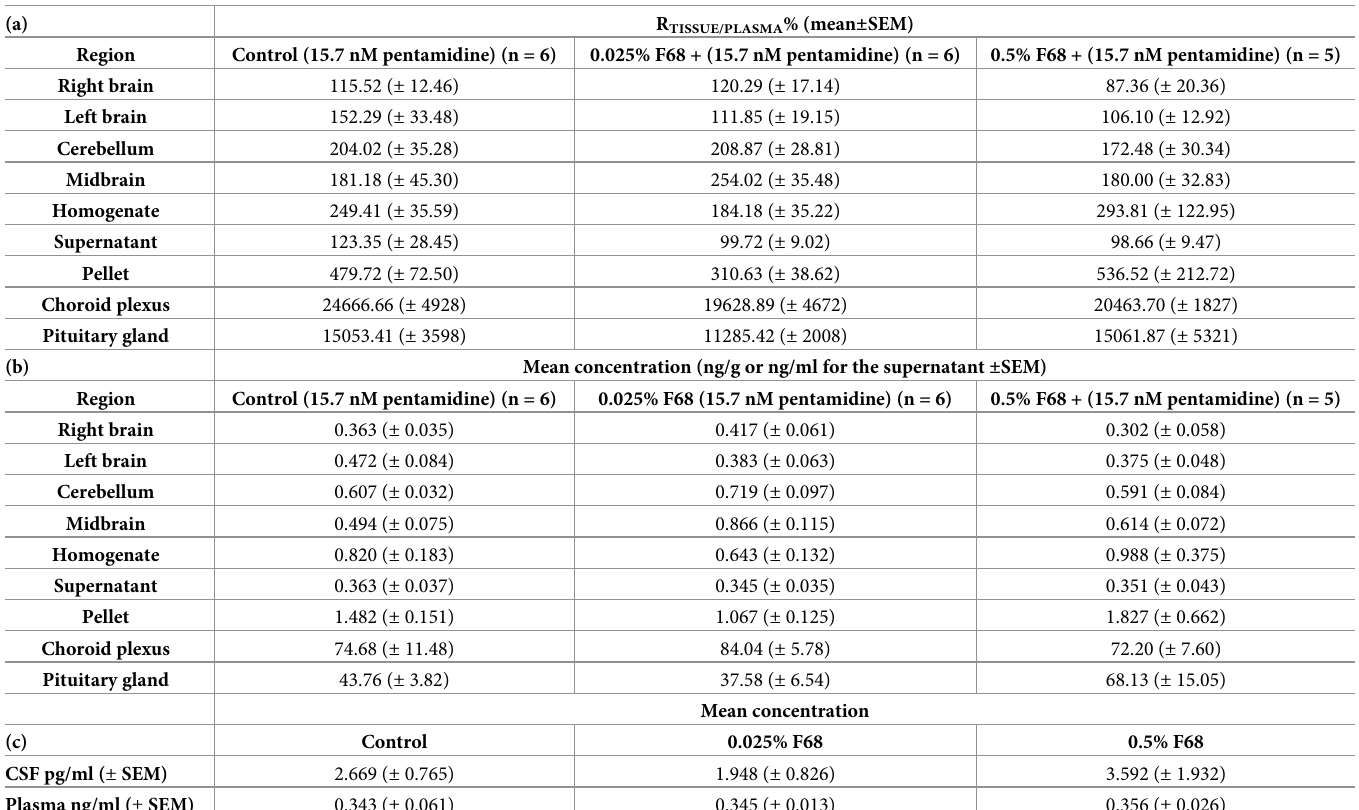
Table 10. Uptake of [ 3 H(G)]pentamidine into brain tissue (corrected for vascular/[ 14 C]sucrose space) and CSF (corrected for blood/[ 14 C]sucrose contamination)at 2 hours post-injection in BALB/c mice. Data is presented (a) as the tissue/plasma ratio and converted into concentrations in ng/g of tissue (b) and as concentration for the terminal plasma and CSF samples (c). A limitation of measuring pentamidine by scintillation counting is that any metabolites produced during the 2 hours that have retained the radiolabel, will be counted as [ 3 H(G)]pentamidine. These metabolites may have different transport characteristics and may or may not be active against